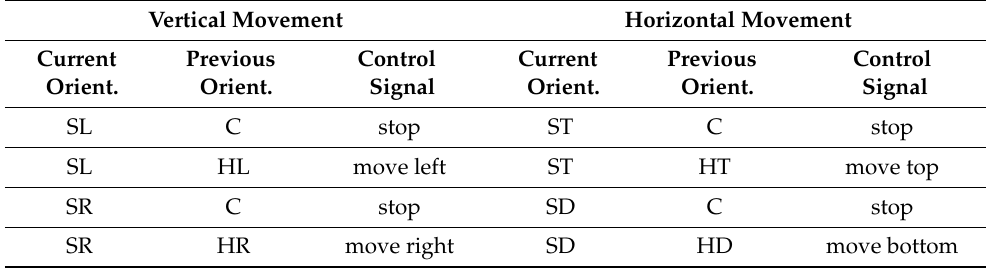
Table 4. Control signals for example pairs of current and previous head orientation